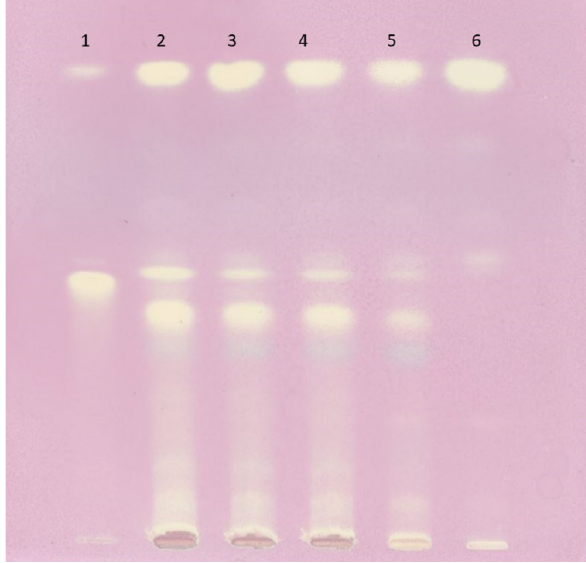
Figure 1: TLC–DPPH test results for the extracts of corn porridge of the varied chokeberry content; plate scanned after 30